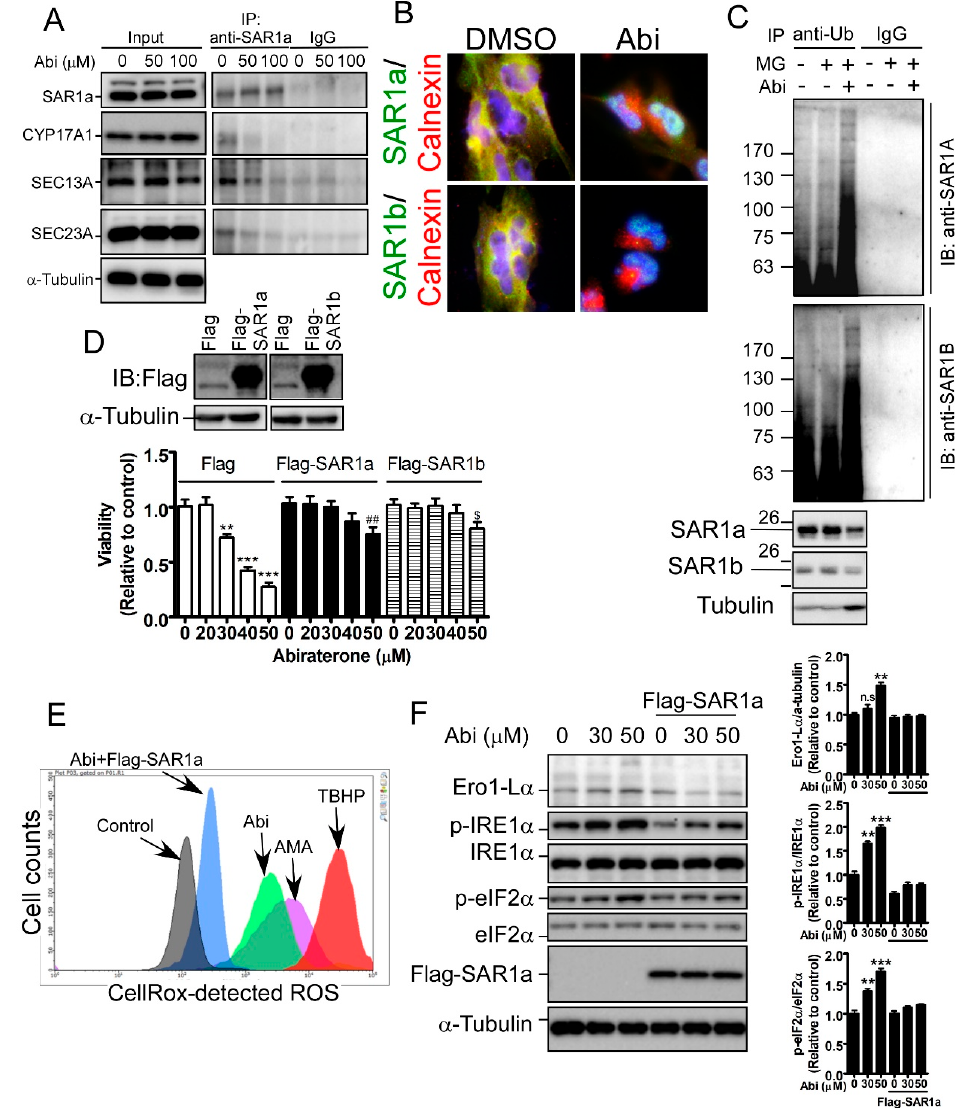
Figure 5. Abi induces ER and oxidative stresses by inducing SAR1a/b ubiquitination. ( A ) After treatment for 6 h, A172 cells were harvested and immuno-precipitated by the anti-SAR1a antibody. The complex was analyzed by western blotting. ( B ) A172 cells with or without Abi treatment for 6 h were stained by immunofluorescence, using antibodies targeting SAR1a, SAR1b, and calnexin. ( C ) After treatment with Abi for 24 h in the presence or absence of 20 µ M MG132, A172 cells were subjected to immunoprecipitation and were analyzed by western blotting, using anti-ubiquitin, anti-SAR1a, and anti-SAR1b antibodies. ( D ) After transfection with Flag-SAR1a or Flag-SAR1b for 24 h, A172 cells were treated with Abi for 48 h. An MTT assay was performed to analyze viability. (** p < 0.01, *** p < 0.001 compared with Flag-transfected group without treatment; ## p < 0.01 compared with Flag-SAR1a-transfected group without treatment; $ p < 0.001 compared with Flag-SAR1b-transfected group without treatment). ( E ) A172 cells with or without Flag-SAR1a overexpression were treated with 50 µ M Abi for 48 h, and ROS levels were determined by CellROX-mediated analysis. AMA and tert-butyl hydroperoxide (TBHP) treatments were positive controls for ROS accumulation. ( F ) A172 cells were treated with 50 µ M Abi for 24 h; cell lysates were analyzed by western blotting. Right panel: quantitative results. (** p < 0.01, *** p < 0.001). None significance (n.s.) compared with the control group without Abi treatment was